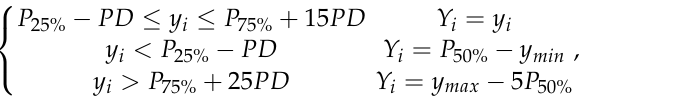
Figure 7. Box plot of SWH effective data for calendar year.